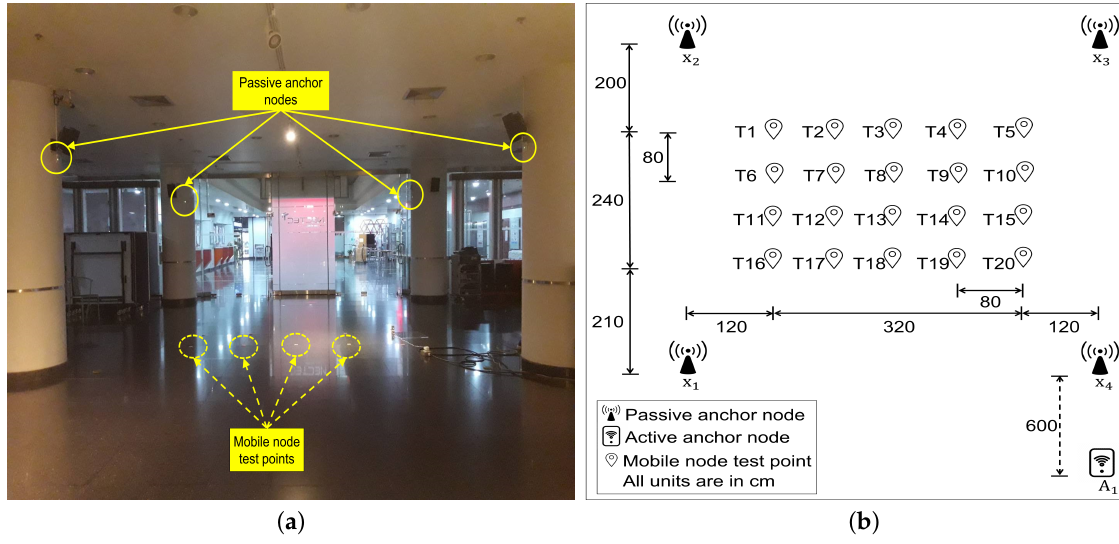
Figure 2. ( a ) Experimental environment. ( b ) Experimental layout (unit: cm). The positions of the active and passive anchor nodes, and the test points for the mobile